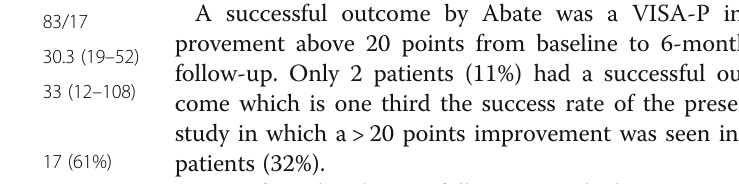
Table 1 Patients demography HVIGI procedures/patients,